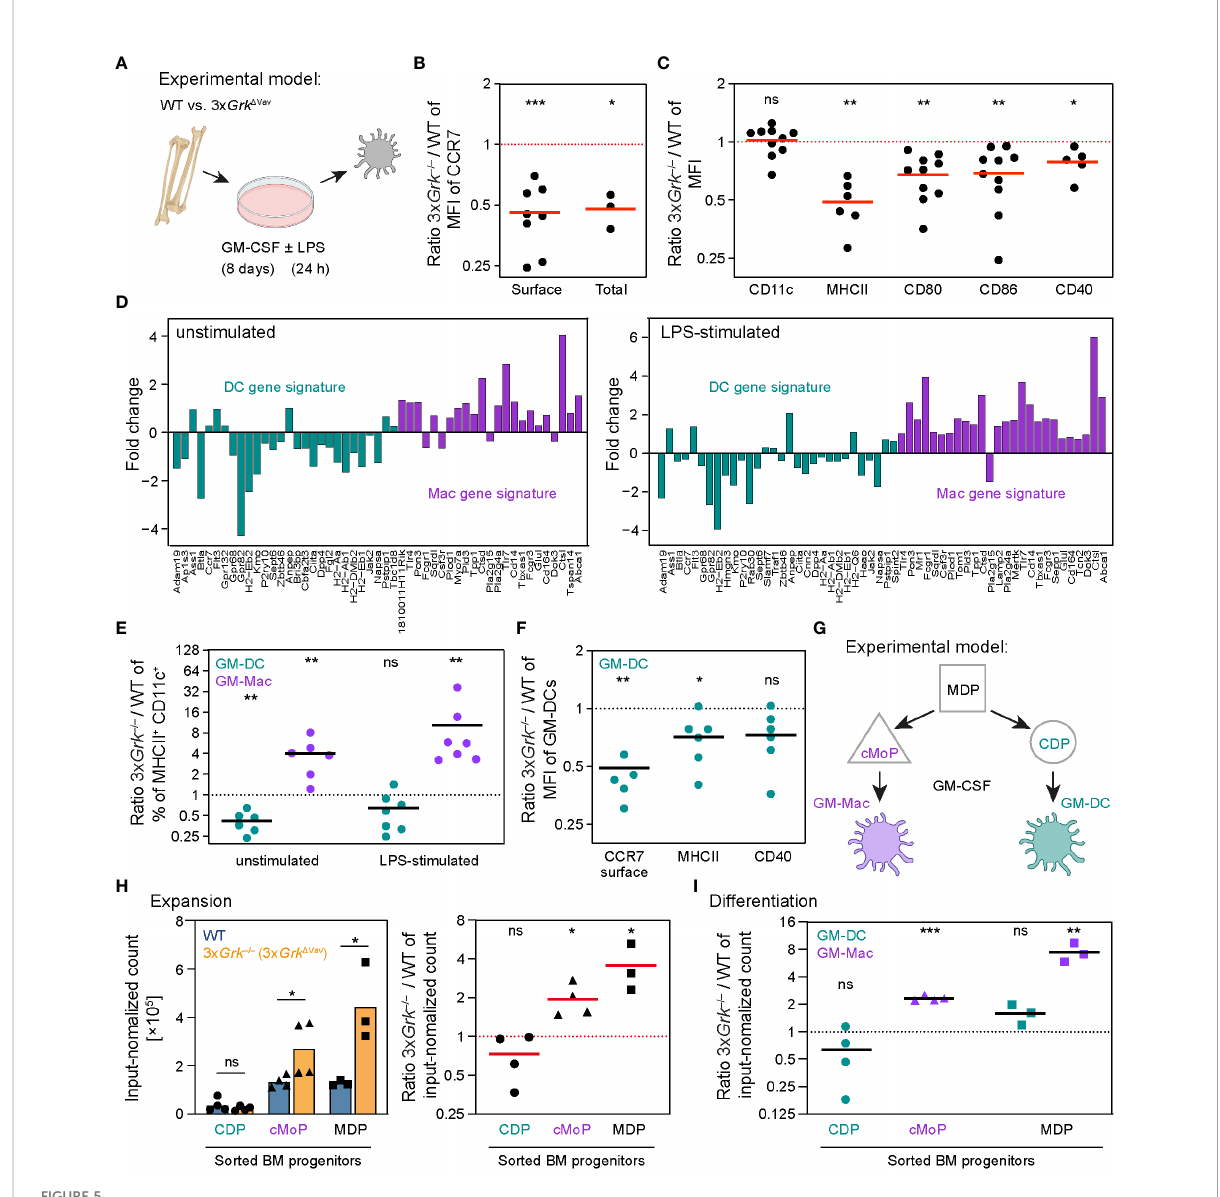
FIGURE 5 Complete GRK depletion impairs DC development in vitro . (A) Scheme of the generation of BMDCs in GM-CSF culture. After 8 days of culture, cells were either left untreated (unstimulated) or stimulated with LPS (LPS-stimulated) for 24 h. (B, C) Quanti fi cation of cell surface and total CCR7 expression levels (B) and surface expression of other markers (C) in CD11c + LPS-stimulated BMDCs. Displayed are ratios of 3x Grk – / – versus WT. n = 3-8 biological replicates performed as independent experiments. Bars display the mean. ** P <0.01, * P <0.05, one sample t test. (D) Bulk RNA-Sequencing of unstimulated (left) and LPS-treated (right) WT and 3x Grk – / – . WT and knockout cells were compared. Fold changes of differentially expressed genes belonging to either a DC (petrol) or macrophage (Mac, purple) gene signature are displayed. (E) Quanti fi cation of bona fi de DCs (GM-DC) and macrophages (GM-Mac) developing in GM-CSF cultures. Displayed are ratios 3x Grk – / – versus WT with or without LPS stimulation. n = 6-7 biological replicates performed as independent experiments. Bars display the mean. ** P <0.01, ns nonsigni fi cant, one sample t test. (F) Quanti fi cation of surface expression levels of DC markers in LPS-stimulated GM-DCs. Displayed are ratios 3x Grk – / – versus WT with or without LPS stimulation. n = 6 biological replicates performed as independent experiments. Bars display the mean. ** P <0.01, * P <0.05, ns nonsigni fi cant, one sample t test. (G) Scheme of precursors generating GM-DCs and GM-Macs in GM-CSF BM cultures. Macrophage-DC progenitors (MDP) can give rise to common DC precursors (CDPs) and common monocyte precursors (cMoPs). (H) Flow cytometric quanti fi cation of the proliferation rate of sorted BM progenitors (CDP, cMoP or MDP) in unstimulated GM-CSF cultures. Displayed are numbers normalized to the input (left) and ratios of 3x Grk – / – versus WT (right). n = 3-4 biological replicates performed as independent experiments. Bars display the mean. * P <0.05, ns nonsigni fi cant, t test (left side CDP,MDP), Mann-Whitney test (left side cMoP), one sample t test (right side). (I) Progenitors (CDP, cMoP or MDP) were sorted from bone marrow before they were grown in GM-CSF-containing medium. After 8 days, differentiation into GM-Mac and GM-DC was analyzed by fl ow cytometry. n = 3-4 biological replicates performed as independent experiments. Bars display the mean. *** P <0.001, ** P <0.01, ns nonsigni fi cant, one sample t